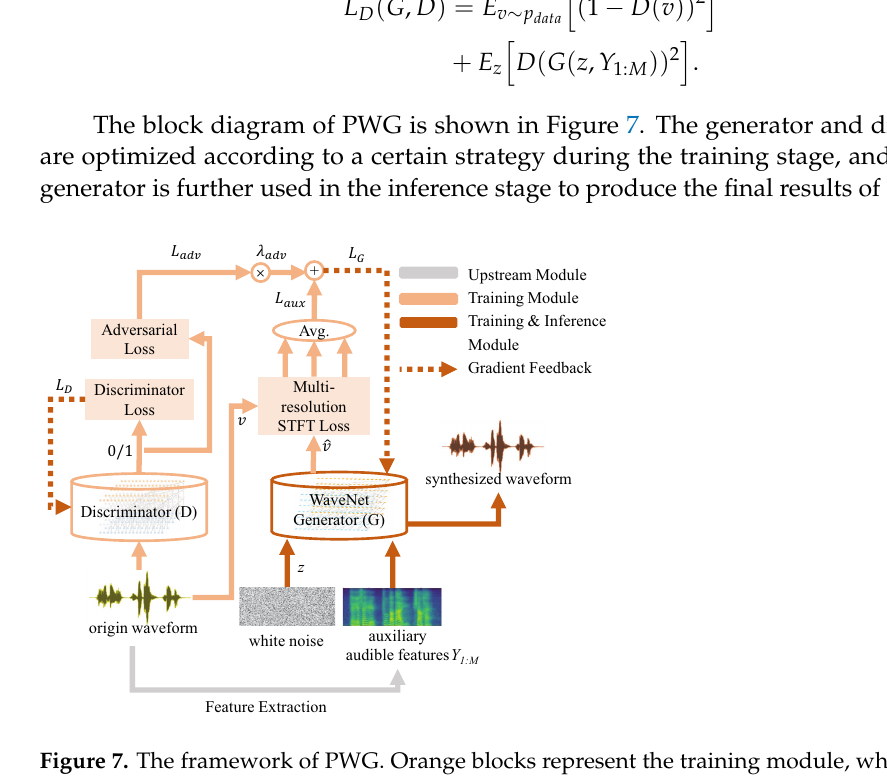
Figure 7. The framework of PWG. Orange blocks represent the training module, while red blocks represent both the training and inference modules. Dotted lines mean gradient